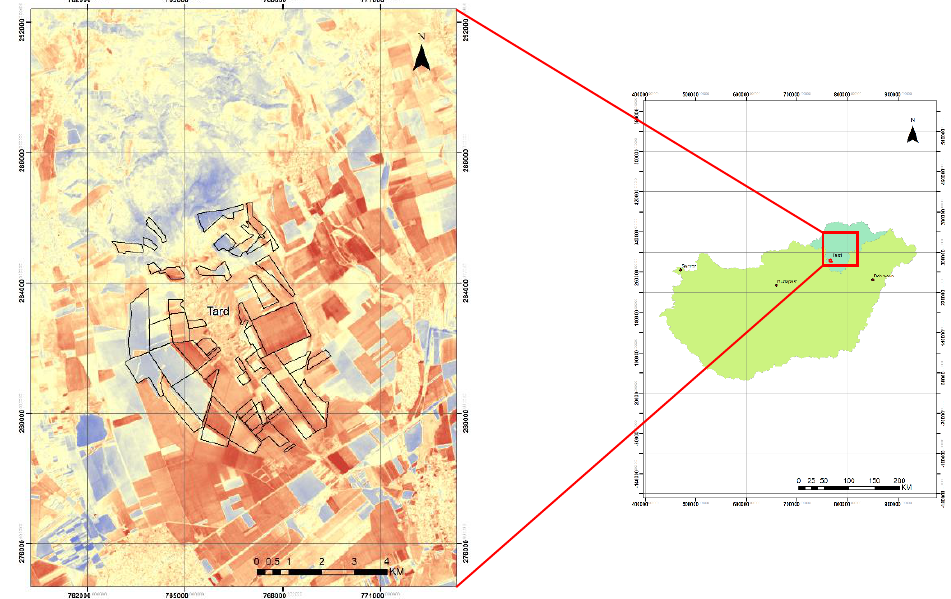
Figure 1. Study area—Tard village located in the western county of Borsod-Abaúj-Zemplén in Hungary.